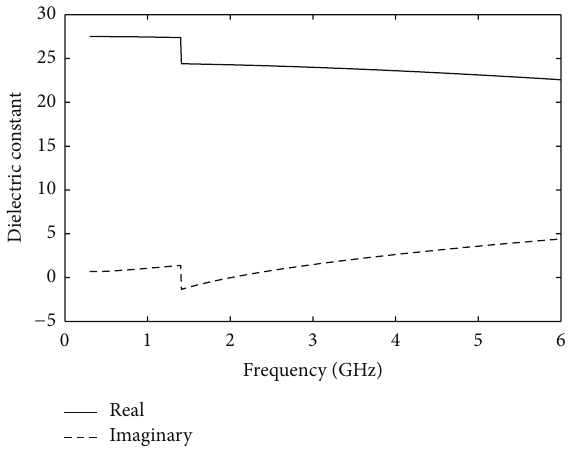
Figure 1: Dielectric constant versus frequency for a soil with 𝑆 = 0.95 , 𝐶 = 0.02 , and 𝜃 = 0.27 .